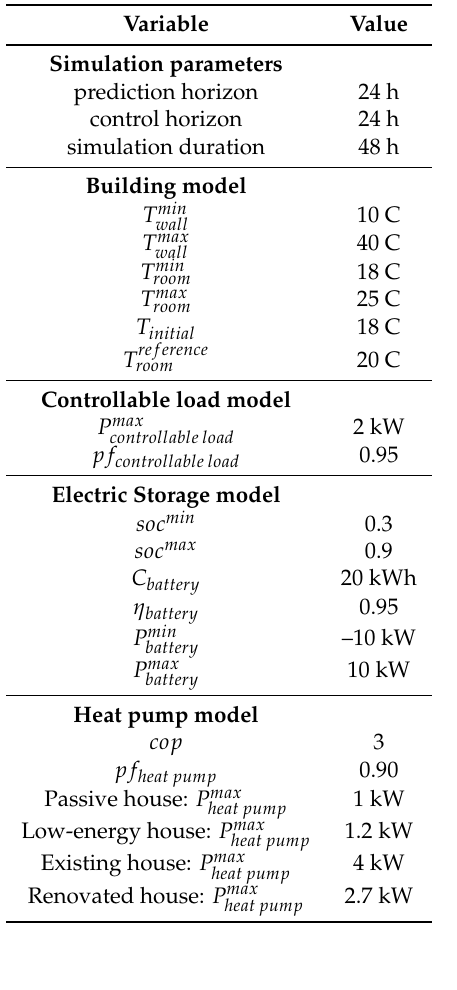
Table 2. Simulation parameters.